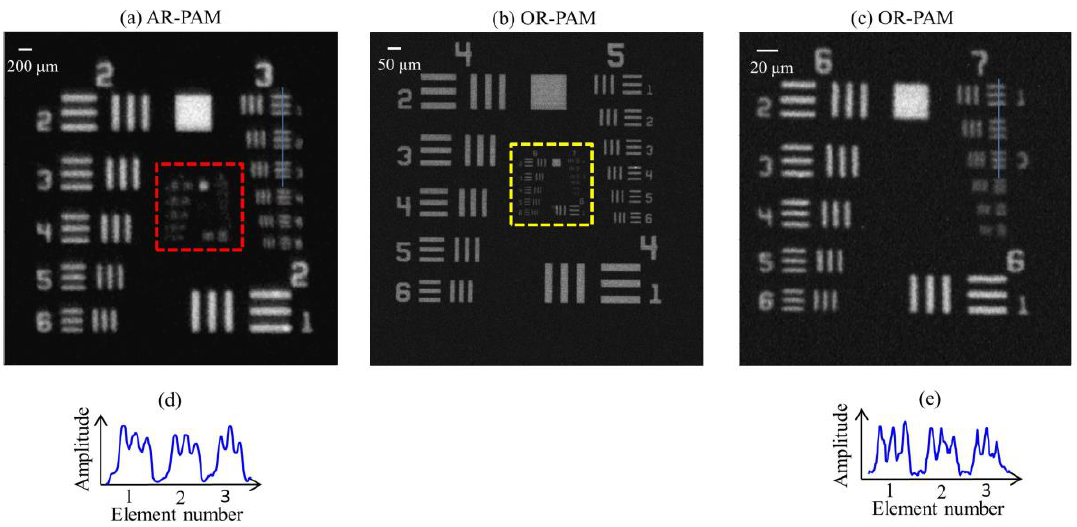
Figure 3. Lateral resolution test of the AR-OR-PAM system: ( a ) AR-PAM image of an air force resolution test target; ( b ) OR-PAM image of the red dotted area; ( c ) OR-PAM image of the yellow dotted region of the test target; ( d ) The cross-sectional profile of the first two elements in Group 3 of the resolution target, blue line in ( a ); ( e ) The cross-sectional profile of the first three elements in Group 7 of the resolution target, blue line in ( c ).